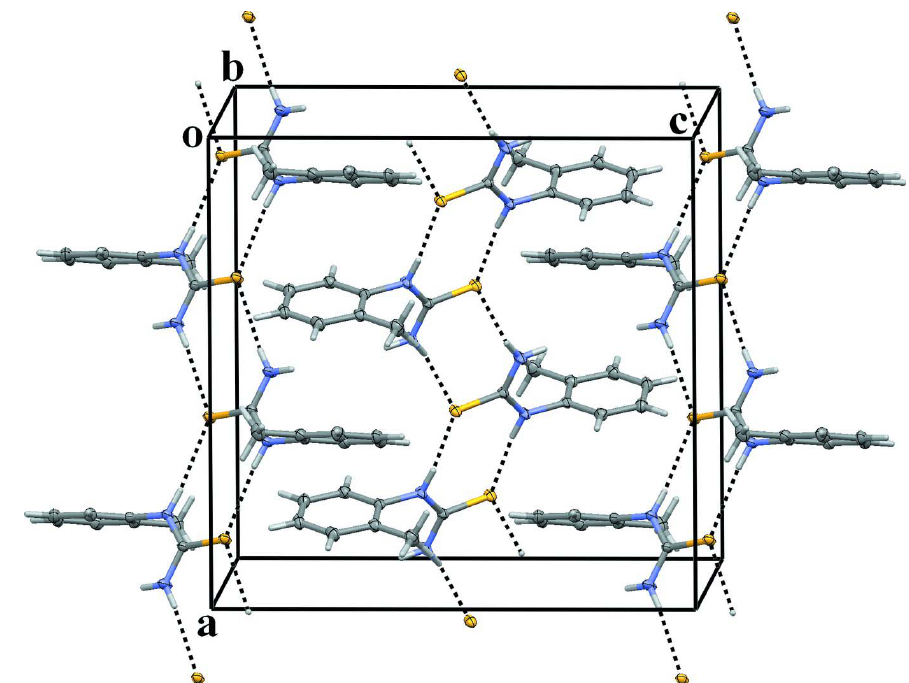
Figure 2 Representation of the chains linked by N—H···S hydrogen